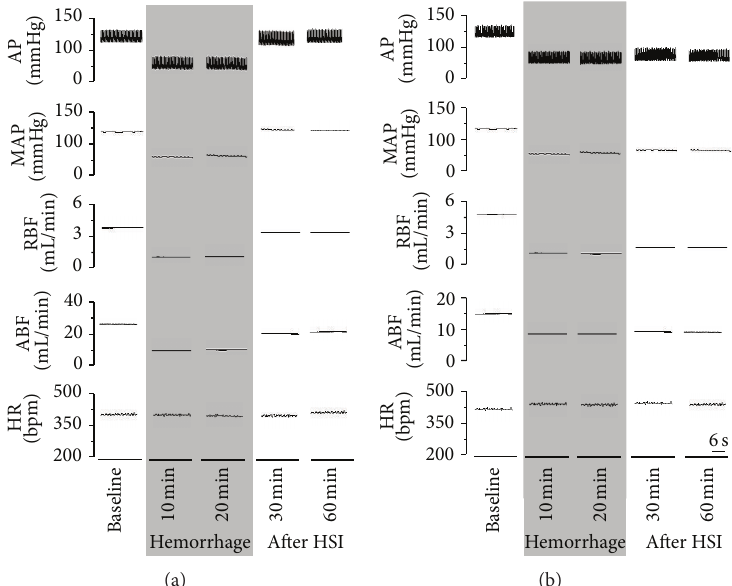
Figure 2: Digitized record of cardiovascular responses to HSI in control (a) and experimental (b) groups. Pulsatile arterial pressure (PAP), mean arterial pressure (MAP), renal blood flow (RBF), aortic blood flow (ABF), and heart rate (HR).